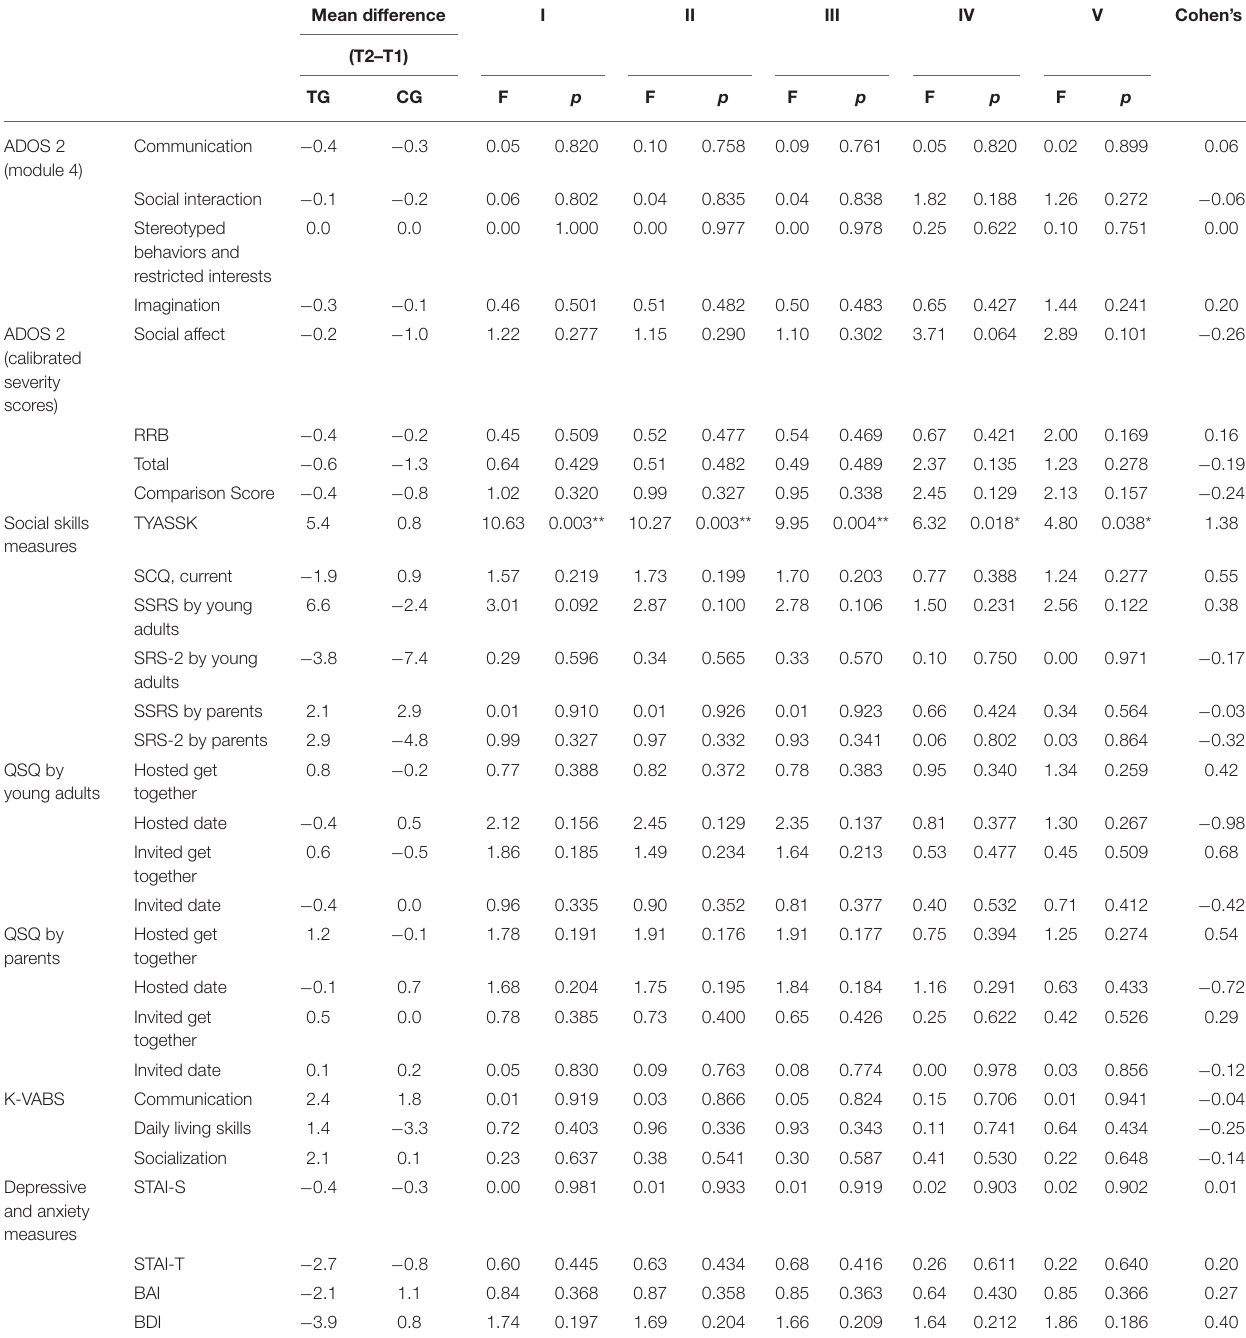
TABLE 2 | Mean differences and effect size with significance for time x treatment differences of each